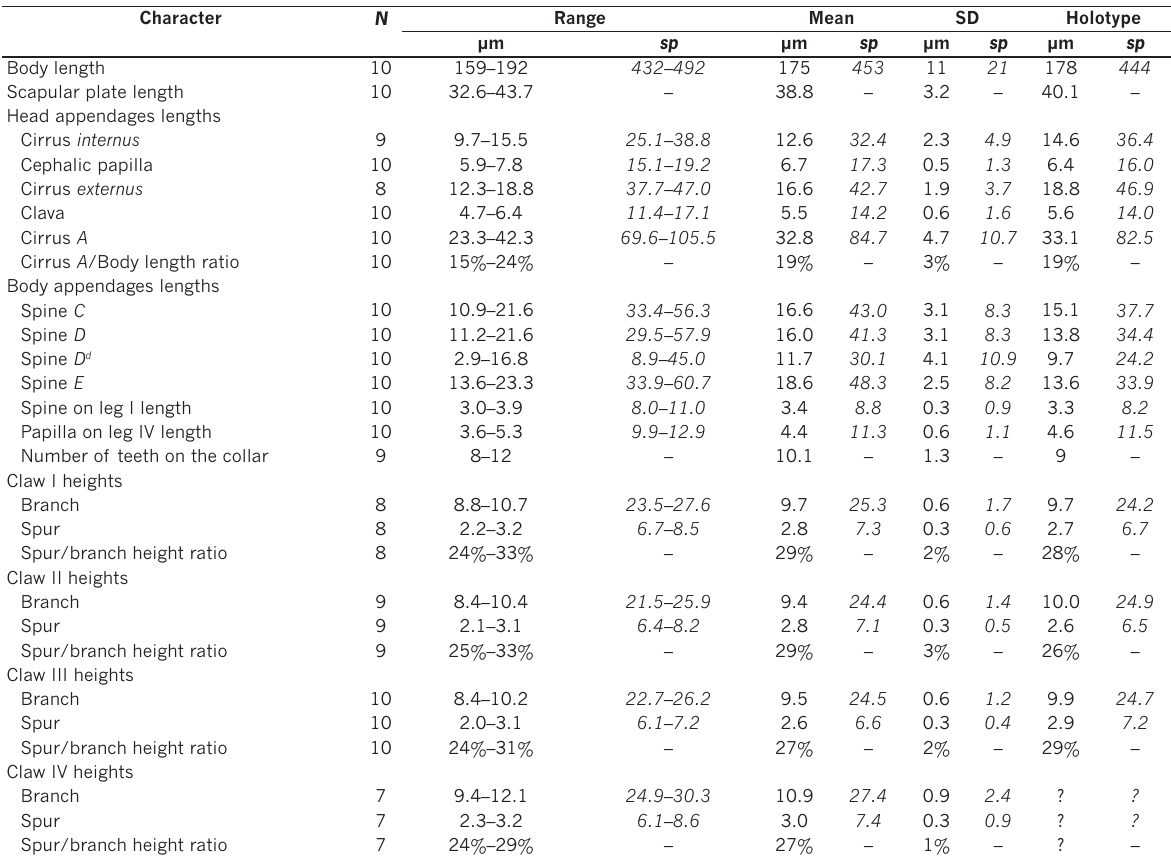
Table 2. Measurements [in µm] of selected morphological structures of the adult females of Echiniscus masculinus sp. nov. mounted in Hoyer’s medium. N – number of specimens/structures measured, RANGE refers to the smallest and the largest structure among all mea - sured specimens; SD – standard deviation; sp – the proportion between the length of a given structure and the length of the scapular